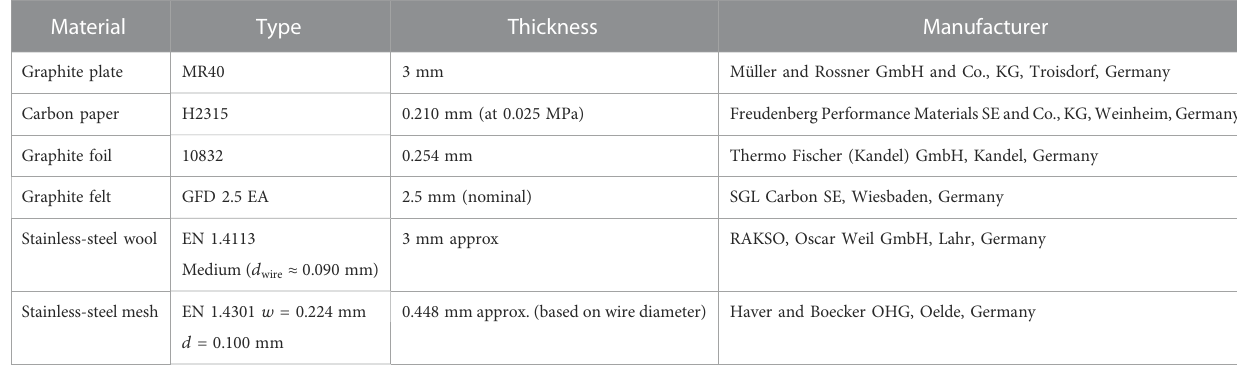
TABLE 1 Materials under study for bio fi lm